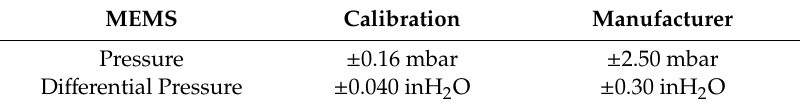
Table 12. Uncertainty of microelectromechanical systems